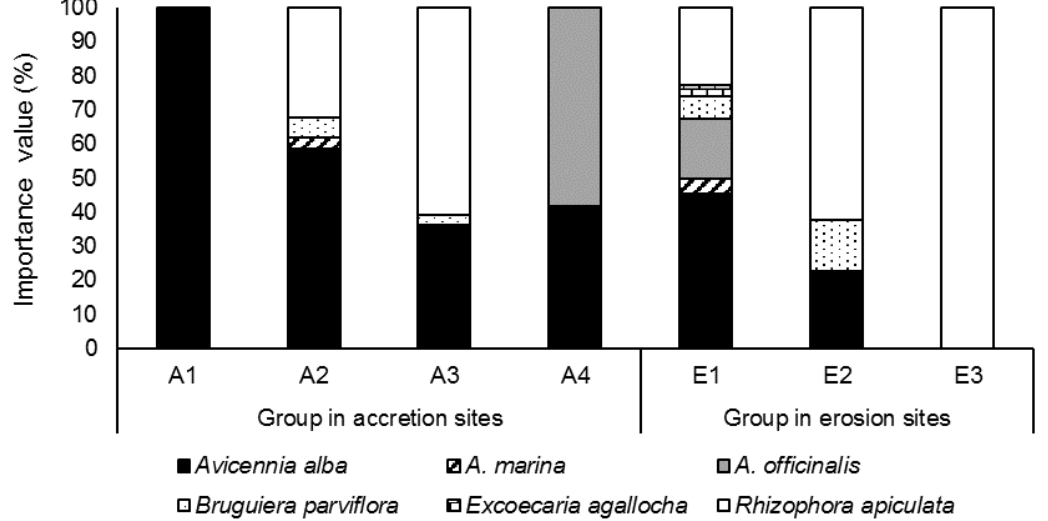
Figure 3. Importance value (%) of species in canopy layer for each group. A1, A2, A3, and A4 represent groups in accretion sites, and E1, E2, and E3 represent groups in erosion